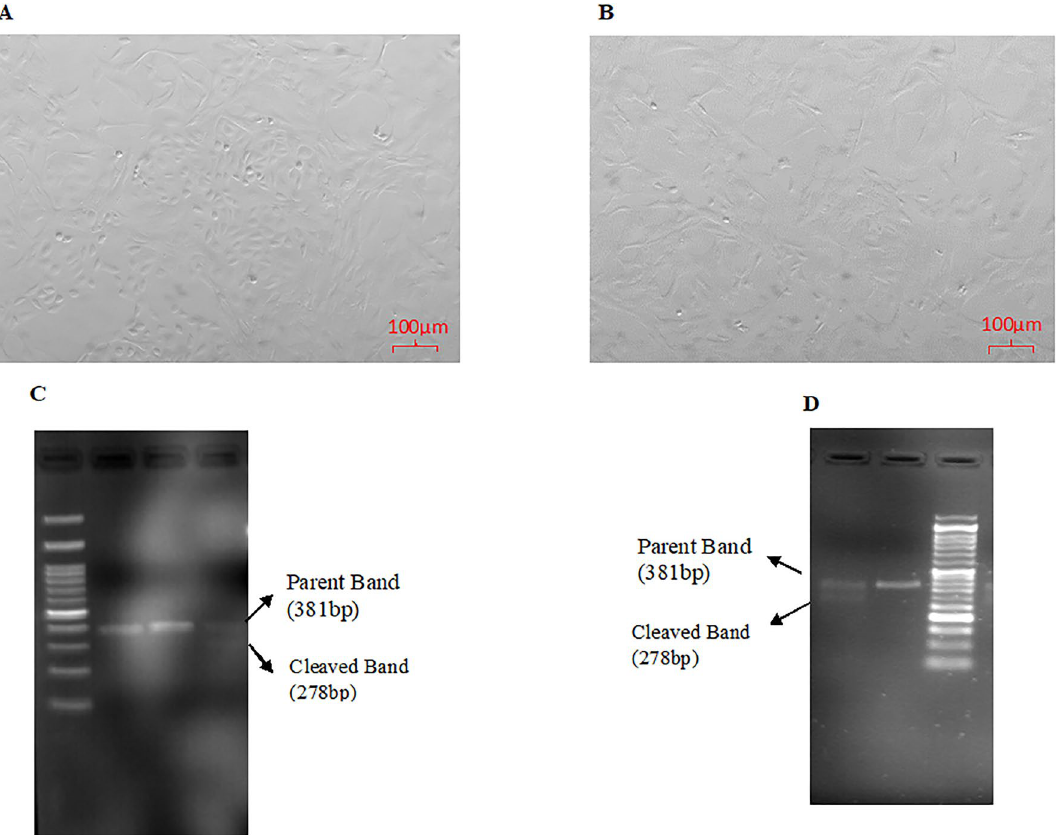
Figure 1. ( A ) 75–80% in vitro cultured caprine granulosa cells. ( B ) In vitro cultured BMPR-IB KO cells. ( C ) Gel image of Genomic Cleavage Detection Assay of granulosa cells transfected with components of CRISPR-Cas system for BMPR-IB gene knock out (KO) using Lipofectamine 2000. Lane 1 and 2: Negative control samples for BMPR-IB KO, Lane3: Genomic cleavage showing both Parent band and Cleaved band. ( D ) Gel image of Genomic Cleavage Detection Assay of granulosa cells electroporated with components of CRISPR-Cas system along with ssODN for BMPR-IB gene knock-in (KI) using Lipofectamine 2000. Lane1: Genomic cleavage showing both Parent band and Cleaved band and Lane2: Negative control sample for BMPR-IB knock-in